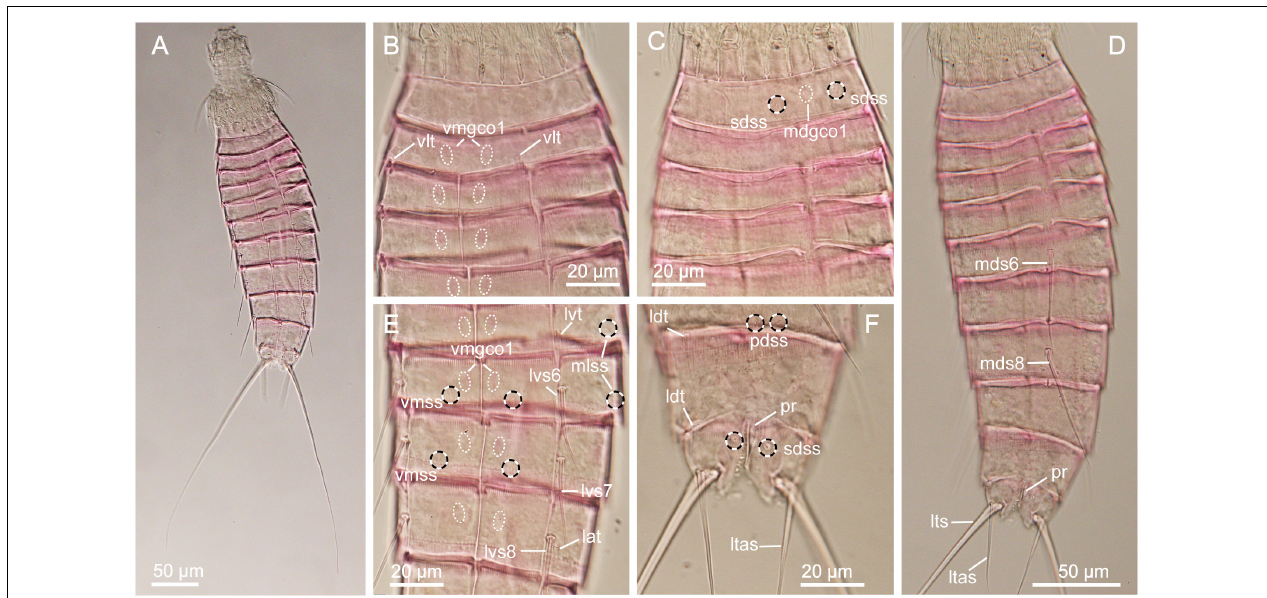
FIGURE 7 | Light micrographs showing overview and details of female Echinoderes sp. 1 (NHMD-872653) collected at station 6. (A) Ventral overview. (B) Segments 1 to 5, ventral view. (C) Segments 1 to 5, dorsal view. (D) Dorsal overview. (E) Segments 5 to 8, ventral view. (F) Segments 9 to 11, dorsal view. lat , lateral accessory tube; ldt , laterodorsal tube; ltas , lateral terminal accessory spine; lts , lateral terminal spine; lvs , lateroventral spine, followed by segment number; lvt , lateroventral tube; mdgco1 , middorsal glandular cell outlet type 1; mds , middorsal spine, followed by segment number; mlss , midlateral sensory spot; pdss , paradorsal sensory spot; pr , protuberance; sdss , subdorsal sensory spot; vlt , ventrolateral tube; vmgco1 , ventromedial glandular cell outlet type 1; vmss , ventromedial sensory